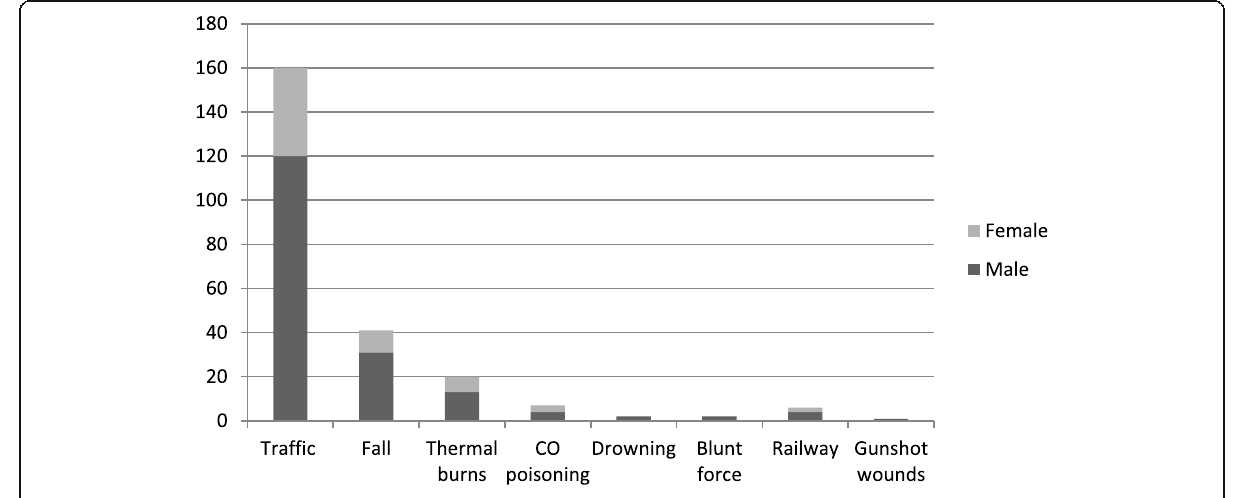
Fig. 1 The number and gender of victims for each type of